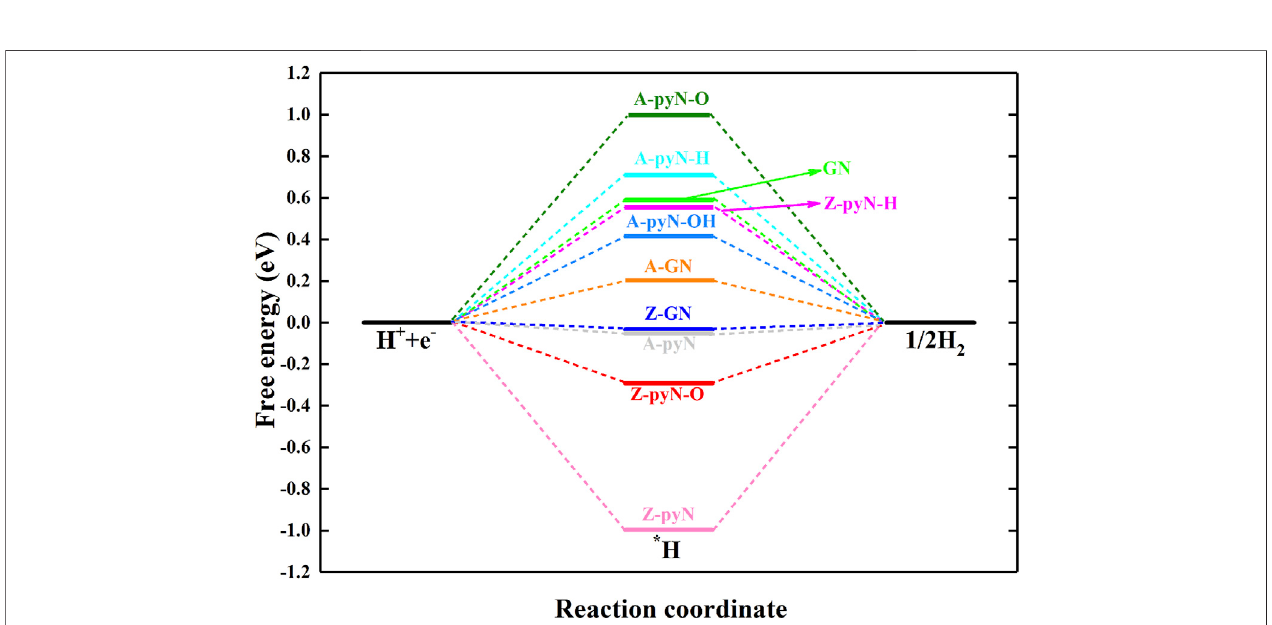
FIGURE 5 | The free energy changes for hydrogen evolution reaction (HER) on various N-doped graphene.